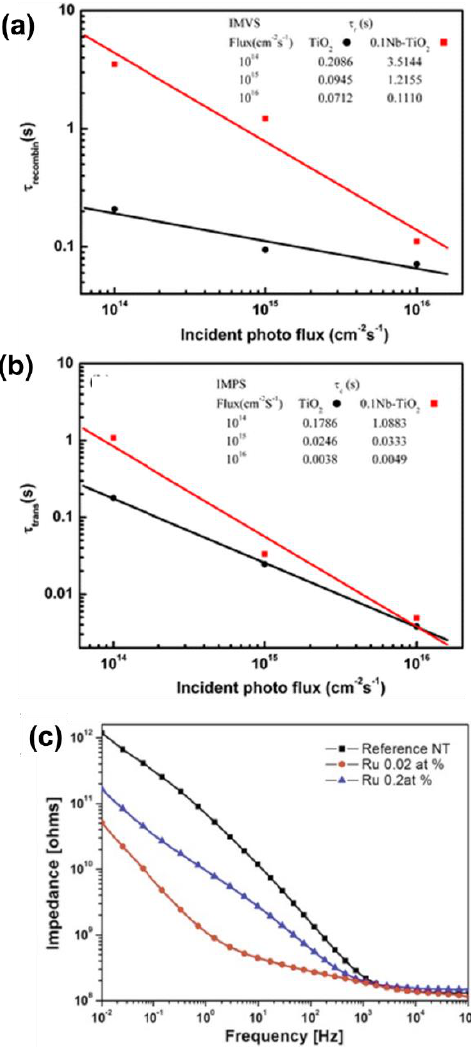
Figure 10. ( a ) Recombination time ( τ r ) and ( b ) electron transfer ( τ c ) constants calculated from IMVS and IMPS measurements for pure TiO 2 and 0.1 Nb–TiO 2 nanotube-layer-based DSSCs. ( c ) Electrochemical impedance measurements of TiO 2 and Ru-doped TiO 2 nanotubes in 0.1 M Na 2 SO 4 . Reproduced with permission from ref [168]. Royal Society of Chemistry (2010) and reference [114]. WILEY-VCH Verlag GmbH and Co. KGaA, Weinheim (2012).